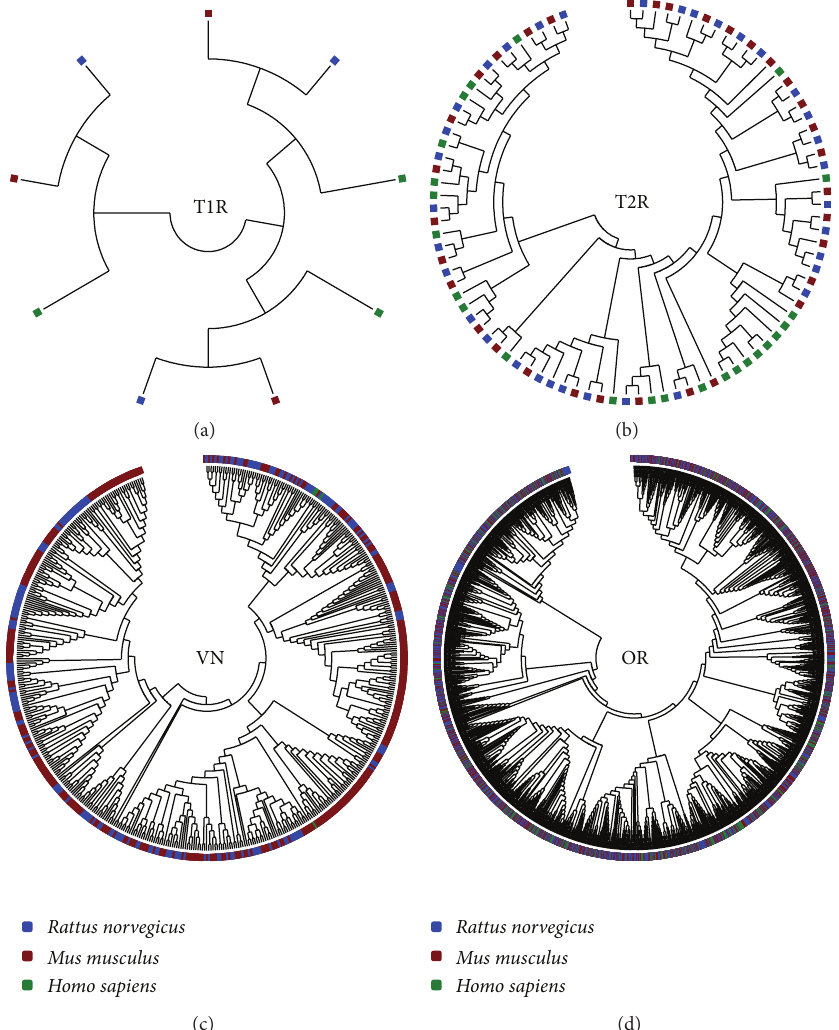
Figure 6: Reconstructed phylogenetic tree of the chemoreceptor families. Each square represents a CR gene. Blue, red, and green squares represent Rattus norvegicus , Mus musculus , and Homo sapiens genes, respectively. Phylogenetic trees were reconstructed with Tamura-Nei model. T1R: type I taste receptors; T2R: type II taste receptors; VN: vomeronasal